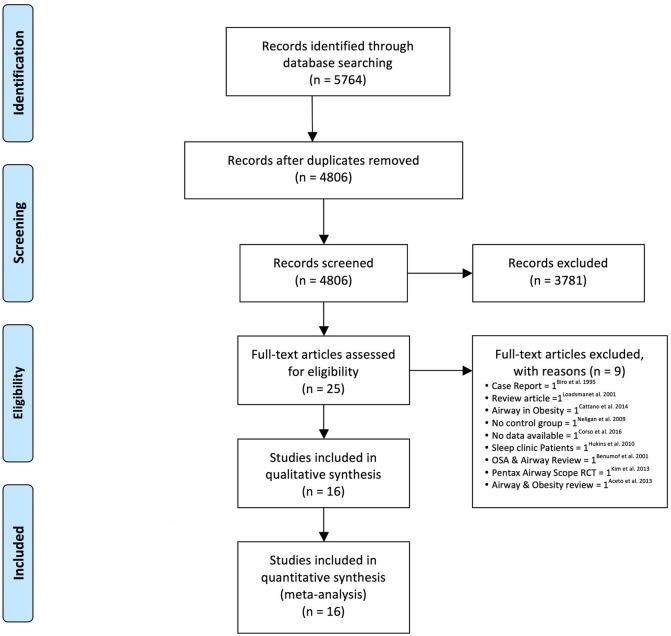
Flow diagram of search strategy used for systematic review and meta-analysis.